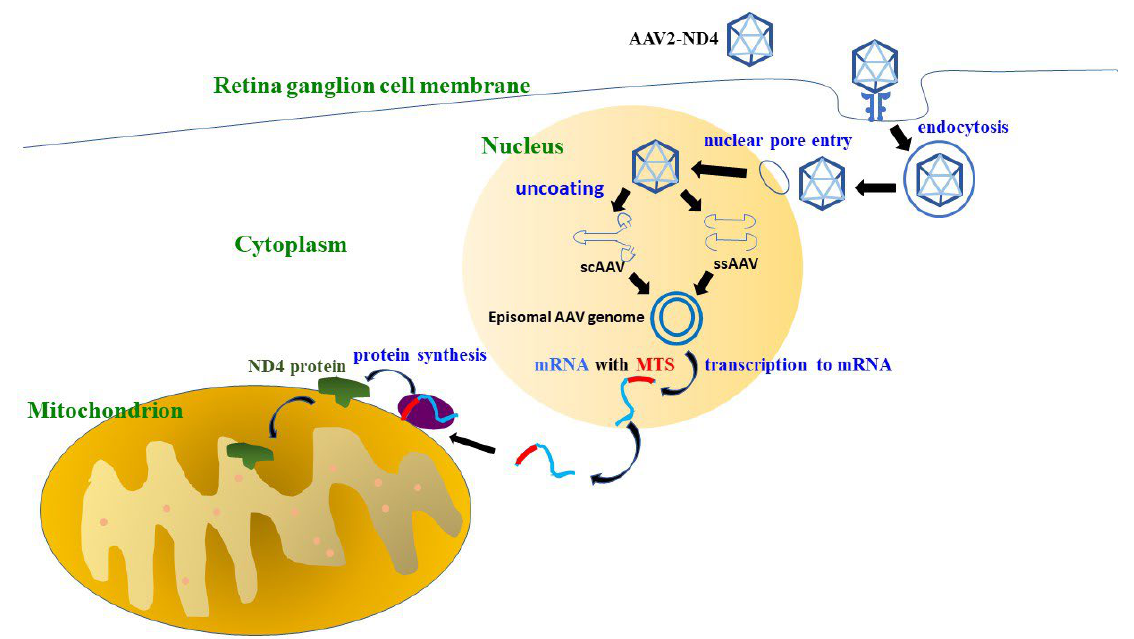
Figure 2. The diagram of the AAV2-ND4 transduction pathway. Clathrin-mediated endocytosis is triggered after AAV2-ND4 is recognized by glycosylated surface receptors on the host cells. Then, AAV2-ND4 passes through the cytosol, shuttles into the nucleus through the nuclear pore, and is uncoated. Single-stranded AAV (ssAAV) and self-complementary AAV (scAAV) transcribe the ND4 mRNA with a mitochondrial targeting sequence (MTS), which helps ND4 mRNA to be delivered to the mitochondrial surface. The ND4 protein is then synthesized and imported into the mi- tochondrion.